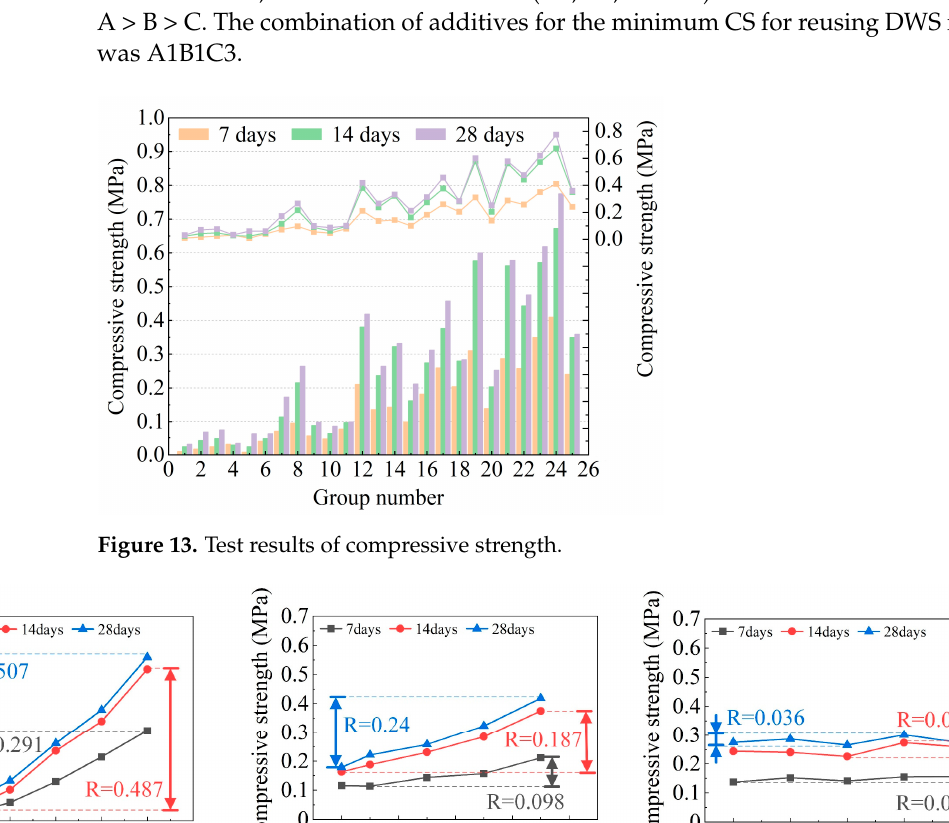
Figure 15. SEM photomicrographs of DWS-GM with 7 days of curing. 7D Group 9: ( a ) 2.0KX ( b ) 5.0KX ( c ) 10.0KX 7D Group 22: ( d ) 2.0KX ( e ) 5.0KX ( f ) 10.0KX.